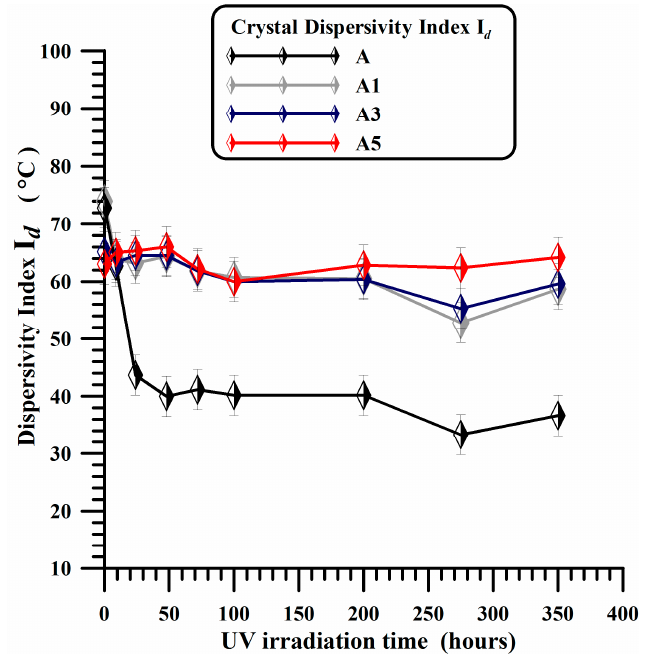
Figure 10. Dispersivity index vs UV irradiation times of A, A1, A3 and A5 samples.